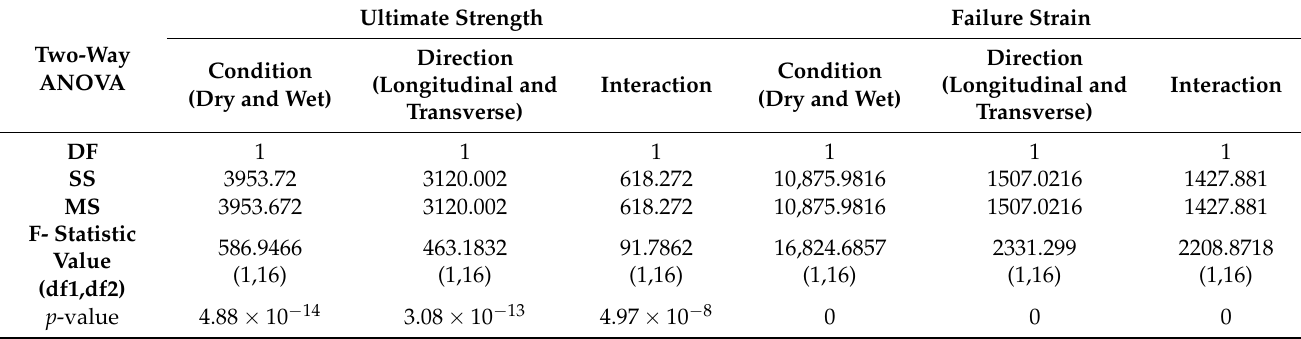
Table 5. Two-way ANOVA results on the tensile properties of Deccani sheep horns-II.